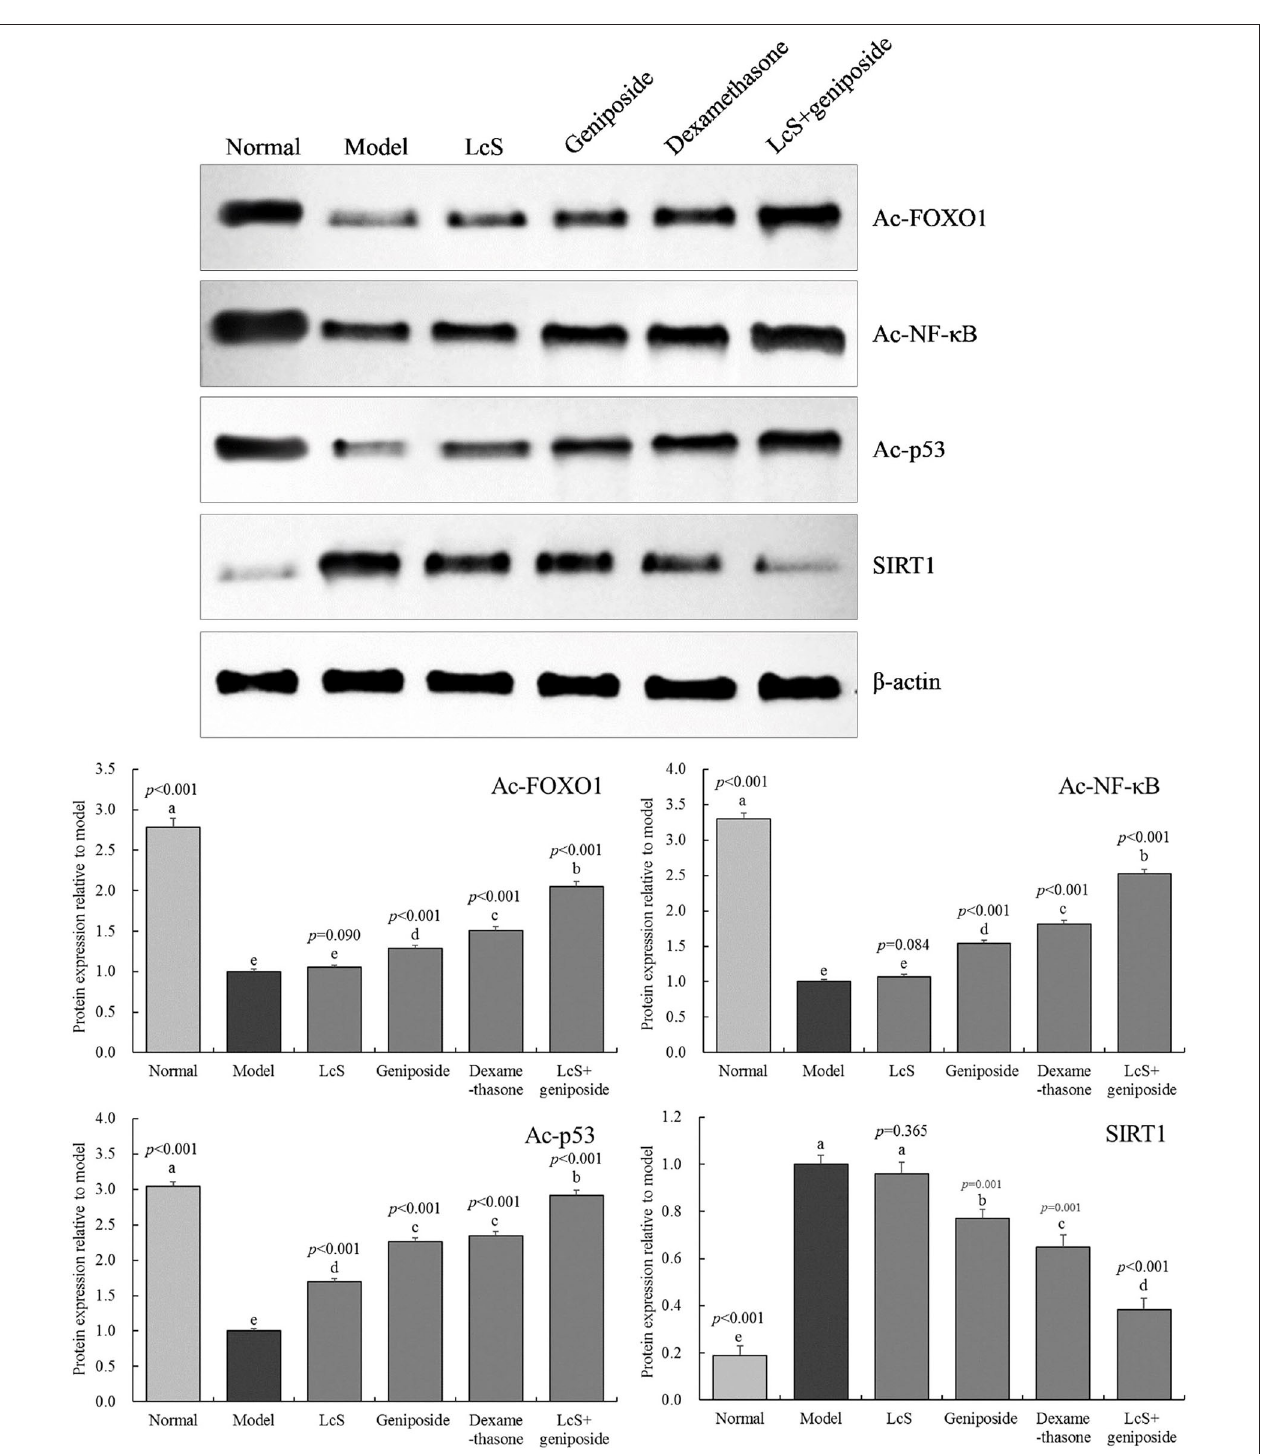
FIGURE 7 | Ac-forkhead box O1 (Ac-FOXO1), Ac- nuclear factor kappa beta (NF- κ B), Ac-p53, and sirtuin type 1 (SIRT1) protein expression of the hippocampus of mice with sepsis on the seventh day ( n = 3). The mean values are tabulated with mean ± standard deviation, and the p -value is the relative situation of the corresponding group to the model group. Normal: untreated mice; model: mice with induced sepsis; LcS: 5 × 10 7 CFU/kg-treated mice with sepsis; geniposide: 50 mg/kg geniposide-treated mice with sepsis; dexamethasone: 1 mg/kg dexamethasone-treated mice with sepsis; LcS + geniposide: 5 × 10 7 CFU/kg LcS and 50 mg/kg geniposide-treated mice with sepsis. a − e Mean values with different letters over the bar are significantly different ( P < 0.05) according to Tukey’s honestly significant difference test.